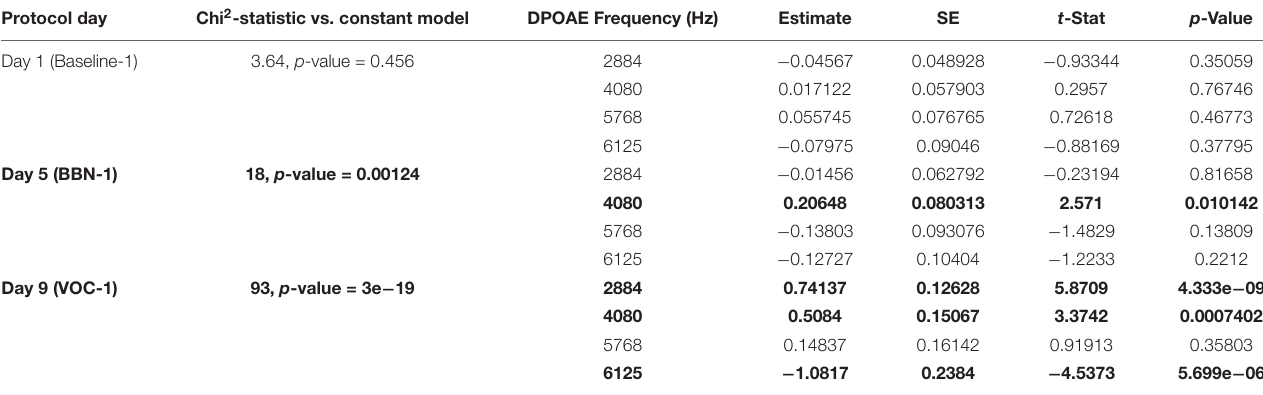
TABLE 3 | The generalized linear models evaluating the association between MOC reflex strength (DPOAE CAS-induced changes) and behavioral performance for ITI-time responses ( > 5 s). Protocol day Chi 2 -statistic vs. constant